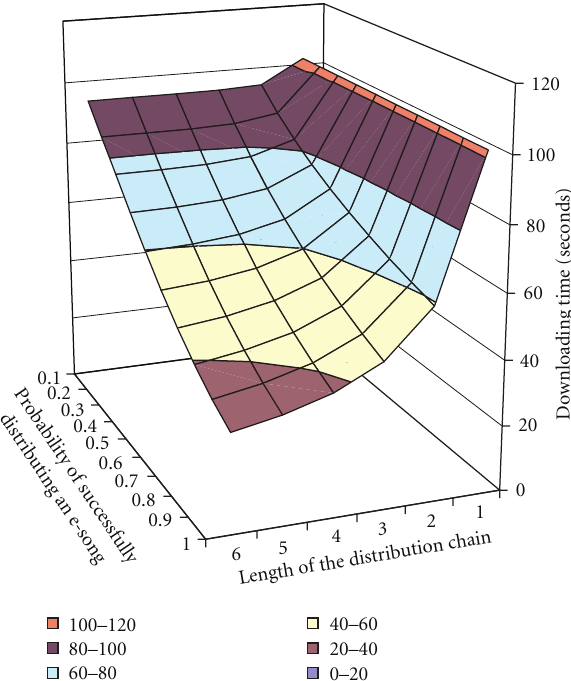
Figure 5: Downloading time (average) in a multichannel distri- bution strategy by coupling the Wi-Fi personal communication technology with 3G cellphone networks.